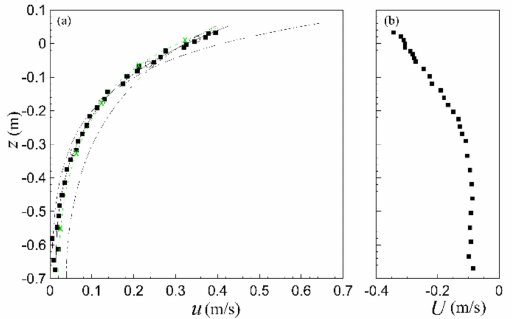
Figure 15. ( a ) The vertical distribution of horizontal velocity and ( b ) measured current profile for non-linear waves interacting with negatively sheared opposing current: experimental data (squares), FNHS mode (solid lines with circles), QNHS mode (dashed lines with X marks), the wave-only solution (dash-dotted lines), and the Doppler-shifted solution (dash-dot-dotted lines).